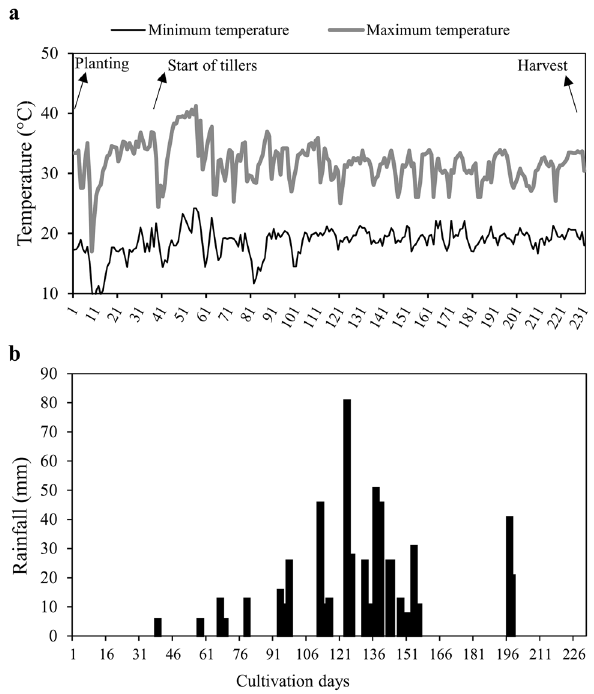
Figure 4. Maximum and minimum air temperature ( a ) and rainfall ( b ) during the development of experiment